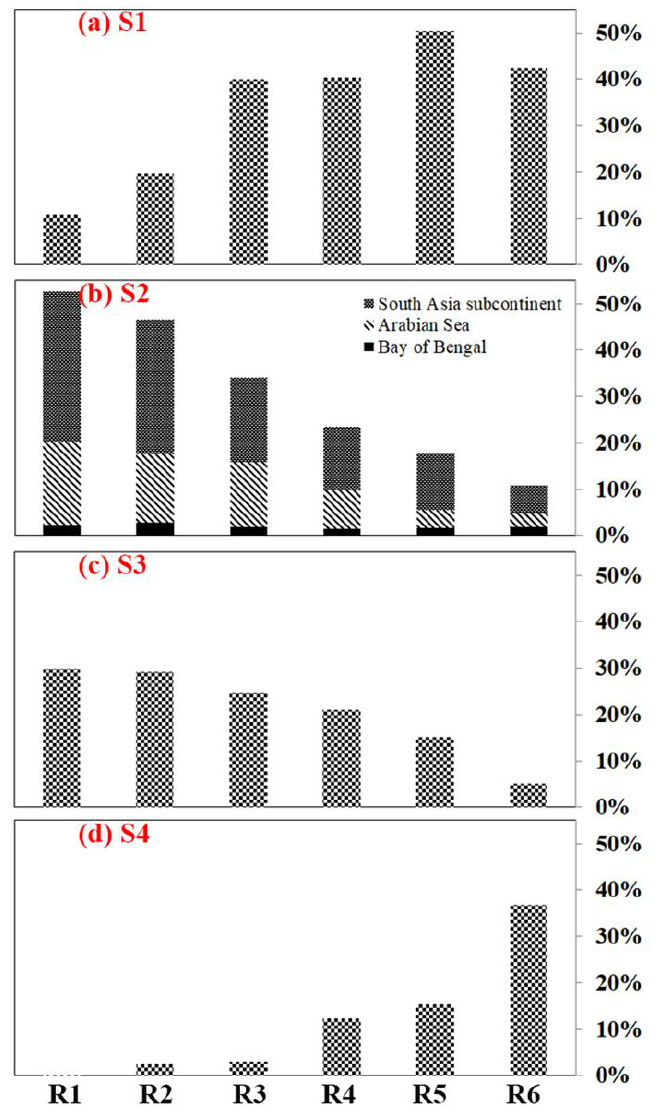
Figure 4. Moisture contribution ratios of the source regions of ( a ) S1, ( b ) S2, ( c ) S3, and ( d ) S4 for extreme precipitation events in each target subregion (R1, R2, R3, R4, R5, and R6).